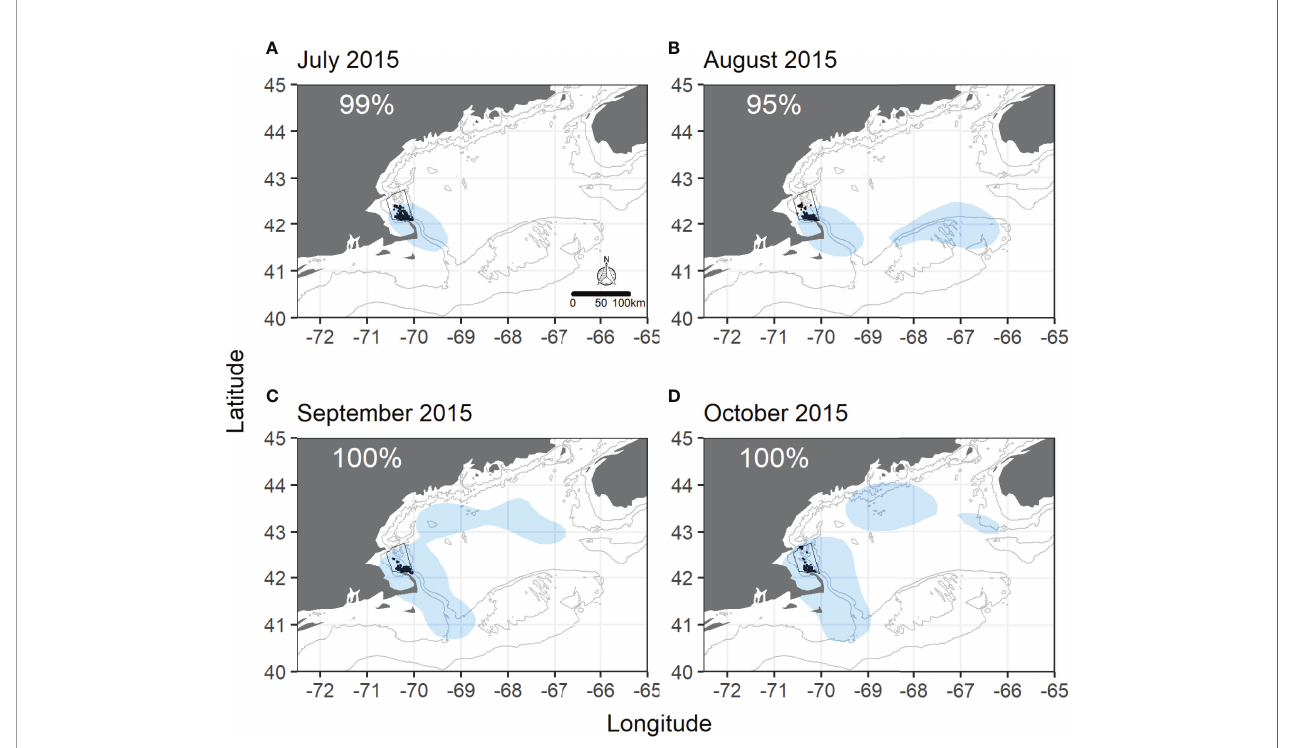
FIGURE 1 | Monthly overlap between great shearwaters and humpback whales within Stellwagen Bank National Marine Sanctuary in 2015. (A) July 2015, (B) August 2015, (C) September 2015, (D) October 2015. Shaded blue areas are shearwater utilization distributions (GOM-wide) from 50% kernel density isopleths. Black dots are daily, unique sightings of individually identi fi ed humpback whales in the sanctuary. SBNMS boundaries are in black. Gray lines represent 50m and 100m depth contours. Percentages represent the percentage of humpback sightings within SBNMS falling within the shearwater